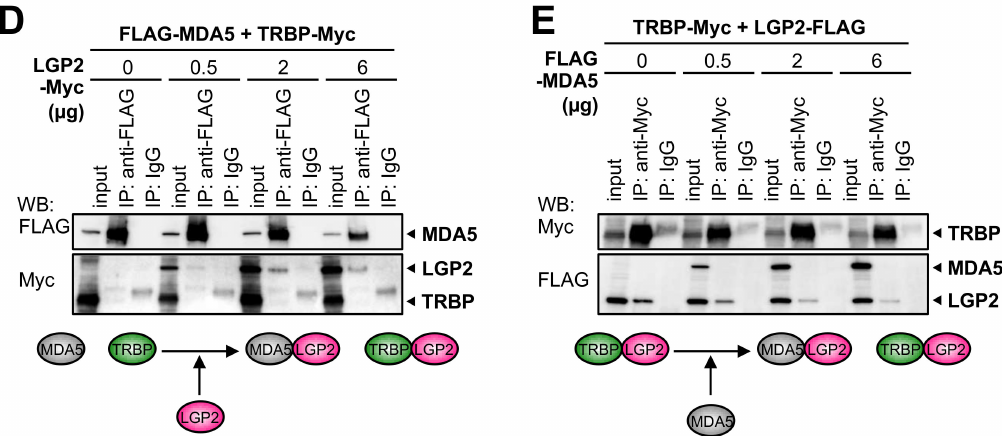
Figure 3. RIG-I interacts with TRBP indirectly through LGP2. ( A ) Immunoprecipitation using HEK293T cells expressing FLAG-TRBP, FLAG-RIG-I, FLAG-MDA5, or FLAG-EGFP with LGP2-Myc protein. TRBP, RIG-I, MDA5, and enhanced green fluorescent protein (EGFP) proteins were immunoprecipitated with anti-FLAG antibody, respectively. LGP2 was detected with anti-Myc antibody. TRBP and EGFP were used as positive and negative controls, respectively. ( B ) Immunoprecipitation using cells expressing TRBP-Myc with LGP2-FLAG, and different concentrations of FLAG-RIG-I. Anti-Myc antibody was used for immunoprecipitation of TRBP, and LGP2 and RIG-I were detected with anti-FLAG antibody. The signal intensities of LGP2 of immunoprecipitate and input, and immunoprecipitated RIG-I were measured using ImageQuant TL (GE Healthcare). The relative ratio of LGP2 signal intensity (immunoprecipitate/input) compared to the control sample without FLAG-RIG-I transfection is shown in pink, and the relative ratio of RIG-I signal intensity compared to the cells transfected with FLAG-RIG-I (6 µ g) is shown in blue. ( C ) Immunoprecipitation using cells expressing FLAG-RIG-I with LGP2-Myc, and different concentrations of TRBP-Myc. The relative ratio of LGP2 signal intensity is shown in pink. The relative ratio of TRBP signal intensity is shown in green. ( D ) Immunoprecipitation using cells expressing FLAG-MDA5 with TRBP-Myc, and different concentrations of LGP2-Myc. ( E ) Immunoprecipitation using cells expressing TRBP-Myc with LGP2-FLAG, and different concentrations of FLAG-MDA5. ( B – E ) Total amount of empty plasmid and TRBP or each RLR construct was unified at 6 µ g in each sample. The presumed results of each protein interaction were shown below each